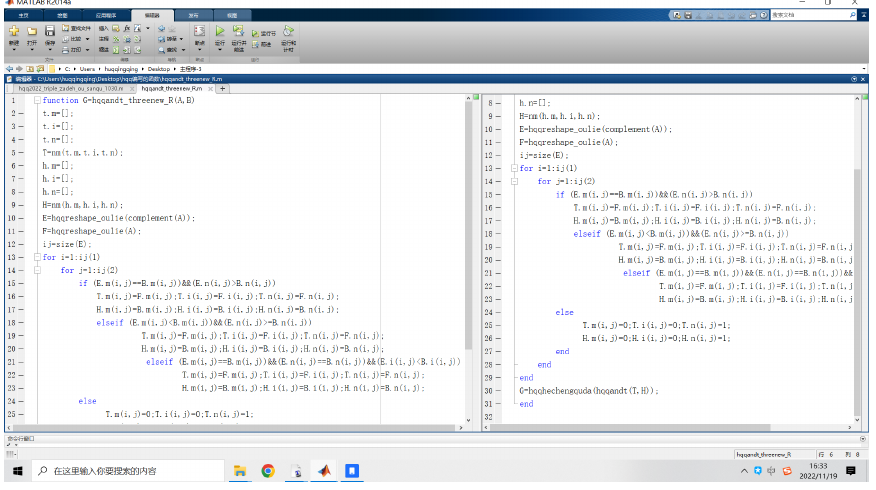
Figure 2. Three-way fuzzy inference based on the proposed triple I